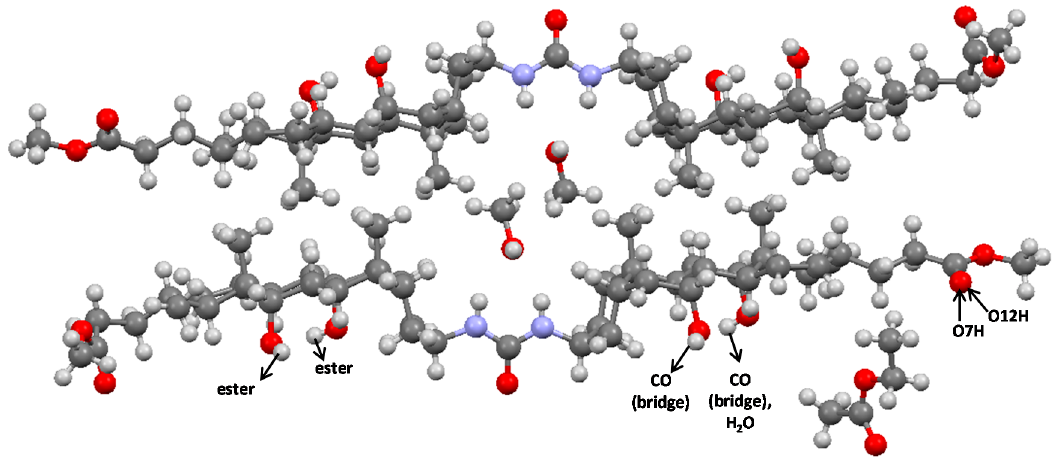
Figure 2. Scheme of the hydrogen bonds involving the two monomers in the dimer 30/AcOEt.